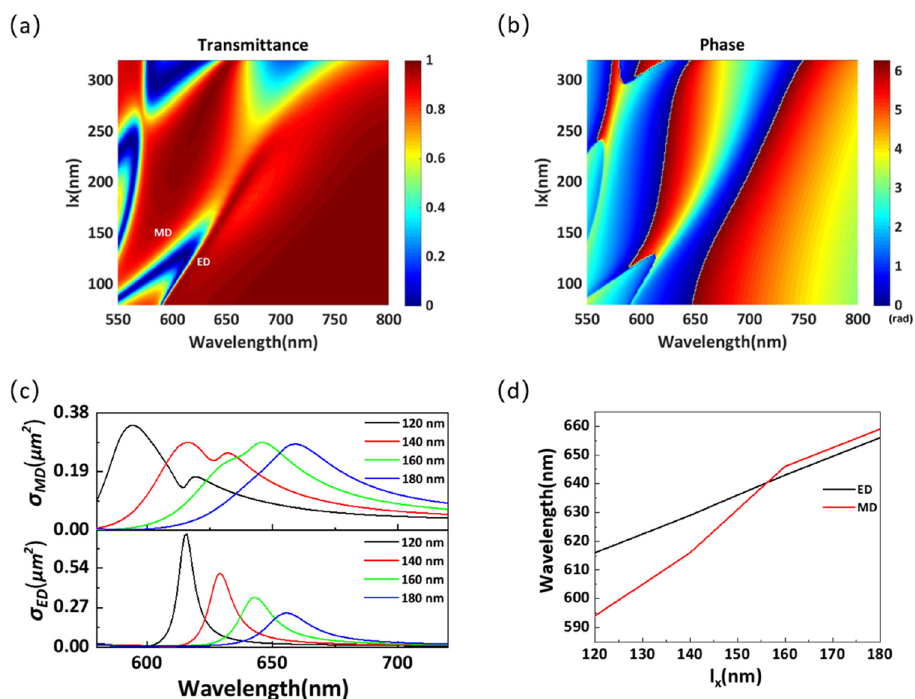
Figure 3. ( a ) Transmittance and ( b ) phase for different structural parameters l x in the wavelength range of 550–800 nm. ( c ) Scattering cross-section for different structural parameters l x in the wave- length range of 550–800 nm. ( d ) Resonant wavelengths of Mie resonances for different structural parameters l x .